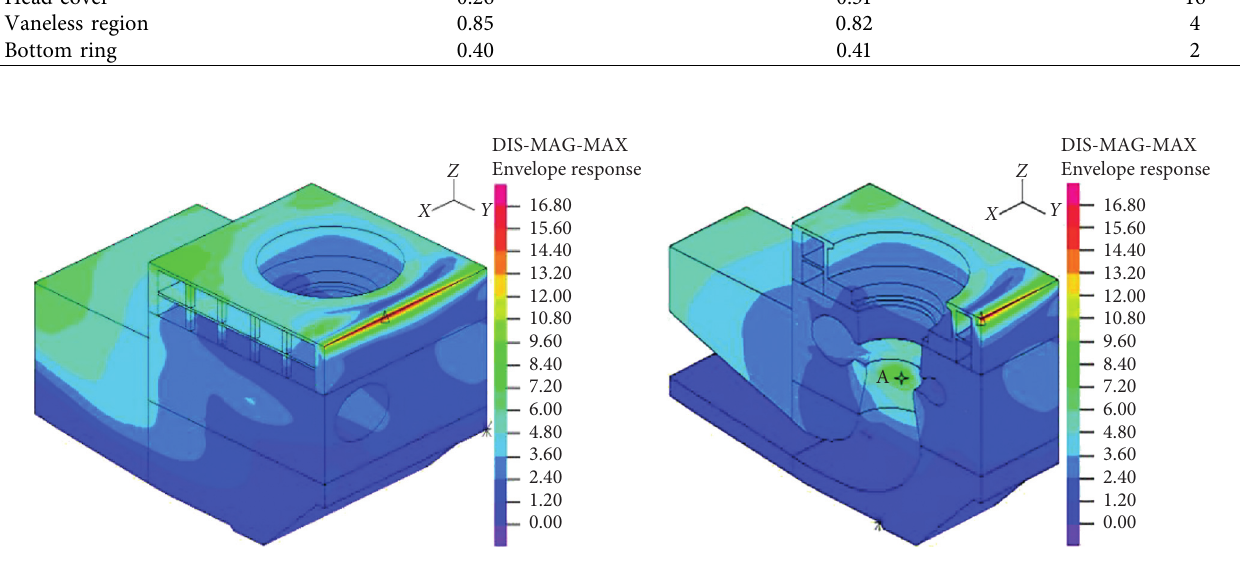
Figure 11: Extreme dynamic displacement distribution of the concrete structure ( μ m). (a) In three-dimensional view. (b) In section